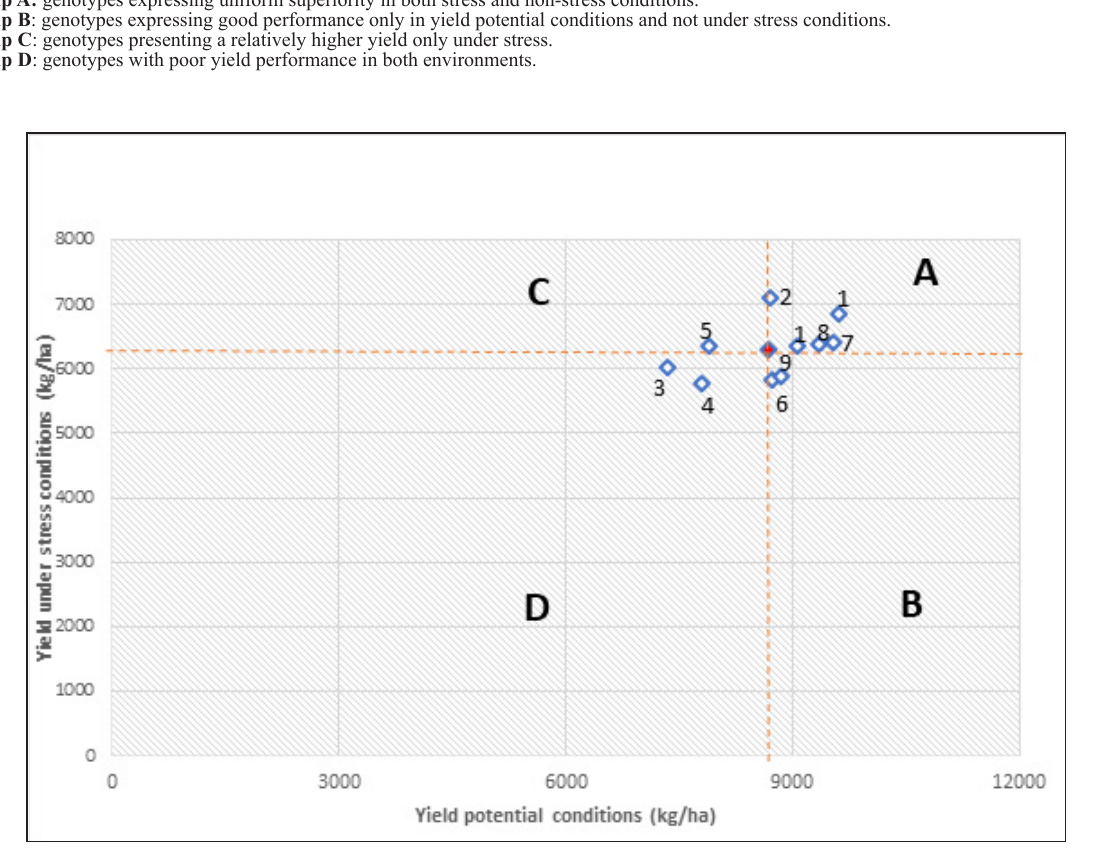
Figure 1. Wheat genotypes ( Triticum aestivum L.) classified based on the average yield under irrigation conditions and under water stress conditions, in groups A, B, C and D (Fernández,